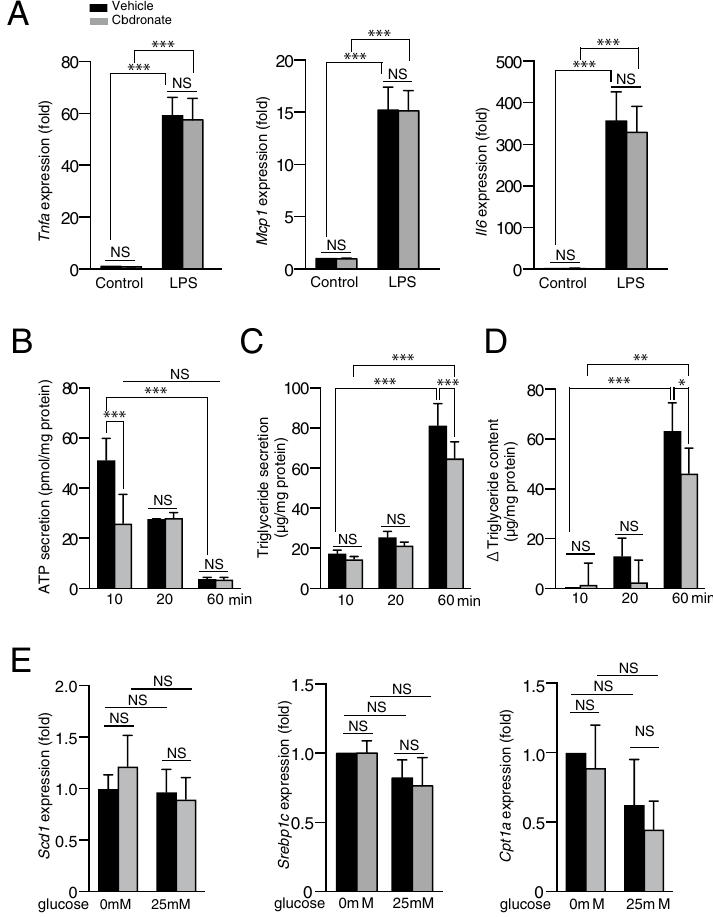
Figure 7. Clodronate inhibits ATP release and triglyceride synthesis but not inflammatory gene expression in mouse primary hepatocytes. Primary hepatocytes were isolated from 10-week-old C57BL/6 male mice. ( A ) Primary mouse hepatocytes were pre-incubated in the presence or absence of 10 µM clodronate for 30 min, followed by stimulation with 1 µg/mL lipopolysaccharide (LPS) or the control (saline) added to the medium. The mRNA levels of the inflammatory cytokine genes, Tnfa , Mcp1 , and Il6 in the mouse primary hepatocytes were determined 4 h after stimulation by qRT-PCR . ( B – D ) Primary hepatocytes were pre-incubated for 20 min with glucose-free Krebs–Ringer bicarbonate buffer with or without 10 µM clodronate, followed by the administration of Krebs–Ringer buffer containing 25 mM glucose with or without 10 µM clodronate for the indicated time. The amounts of ATP ( B ) and triglycerides ( C ) in the culture supernatants, as well as the triglyceride contents in the primary hepatocytes ( D ), were evaluated at the indicated time points. The change in triglyceride content ( D ) was calculated based on the increase from the baseline value (hepatocytes treated with Krebs–Ringer buffer containing 25 mM glucose without clodronate at the time point of 10 min). ( E ) The mRNA expression levels of Scd1 , Srebp1c , and Cpt1a were analyzed by qRT-PCR 60 min after either 0 mM or 25 mM glucose stimulation. Gene expression is shown as the fold change relative to hepatocytes treated with glucose-free Krebs–Ringer buffer. All data are shown as the mean ± S.E.M. * P < 0.05, ** P < 0.01, *** P < 0.001. NS not